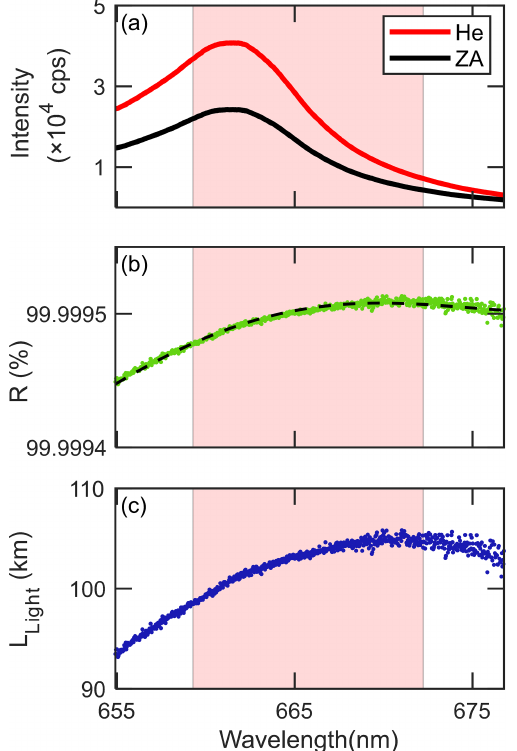
Figure 2. Cavity characteristics of 1min averaged (a) transmitted light intensities with zero air (ZA) and He injection, (b) mirror re- flectivity, R (dashed black line is fitted with fourth-order polyno- mial), and (c) effective light path length, L Light . Shaded area in light red represents fitted range for the number density